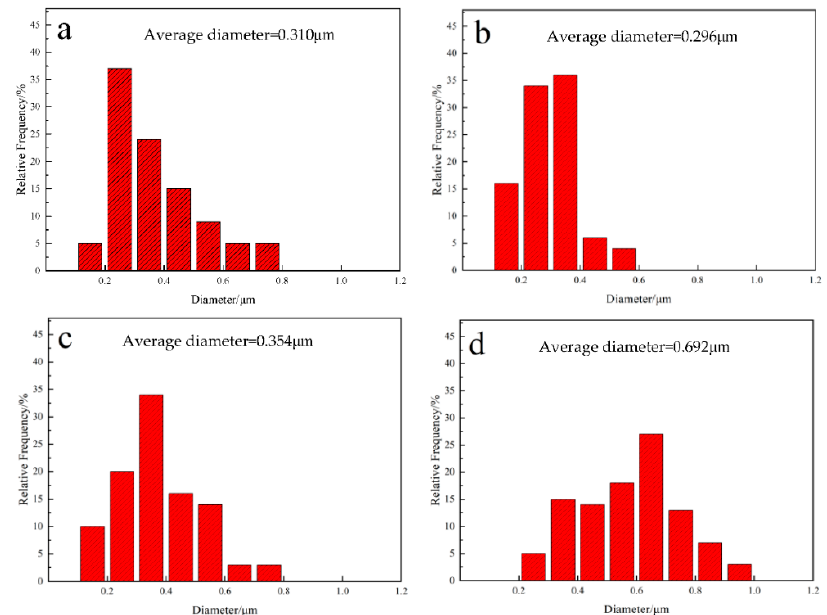
Figure 18. SEM images at different addition of nanographene: ( a ) the addition of 0.5 wt%; ( b ) the addition of 1.0 wt%; ( c ) the addition of 1.5 wt%; ( d ) the addition of 2.0 wt%; ( e ) 1 wt% unmodified nanographene.